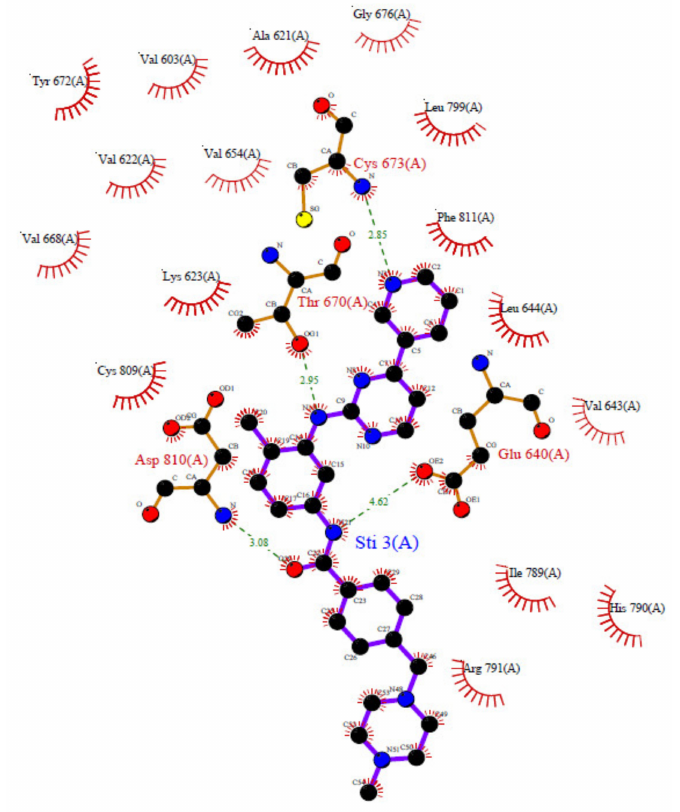
Figure 10. The LIGPLOT of interactions involving the co-crystallized ligand (Imatinib, Gleevec or STI) revealing the most relevant amino acids (E640, T670, C673 and D810) involved in the inhibitor binding into c-kit kinase (PDB: 1t46), through PDBsum